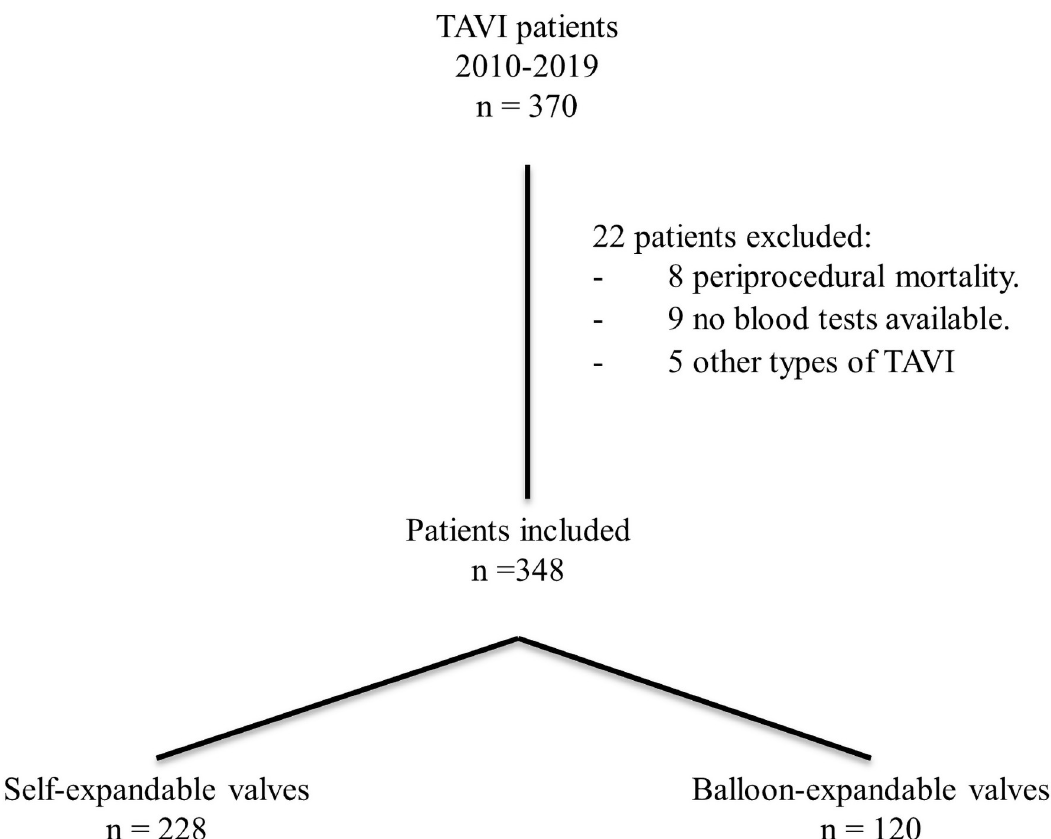
Fig 1. Study flowchart of patients from 2010 to 2019. A total of 370 patients were treated with TAVI. After excluding 22 patients, a total of 348 patients were finally included in the analysis.